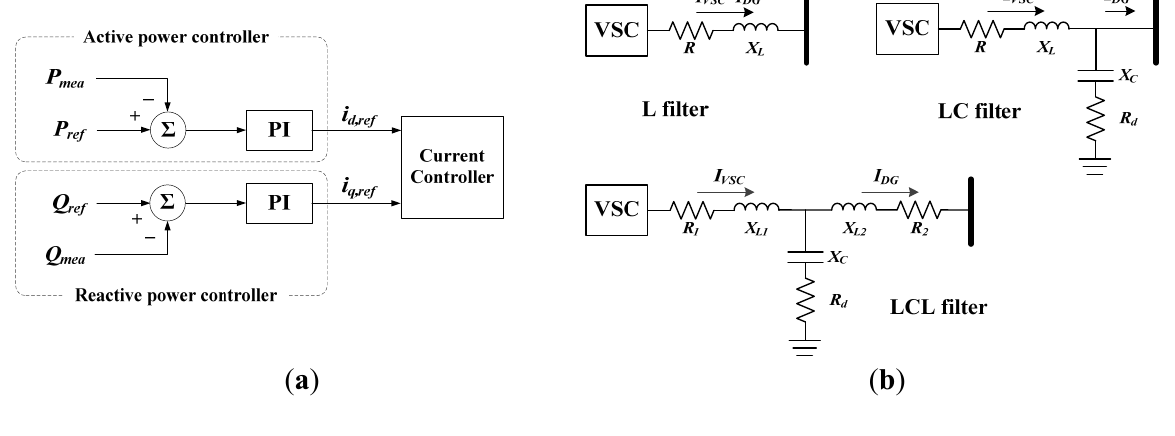
Figure 1. Overview of a vector-controlled DG: ( a ) power control block and ( b ) output filter